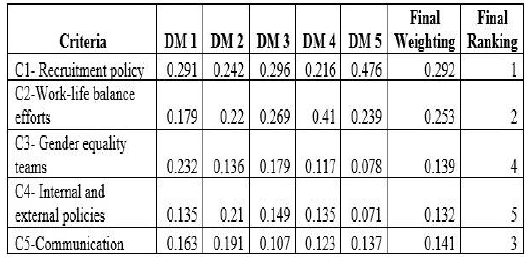
Table 8: Final SWARA Weighting